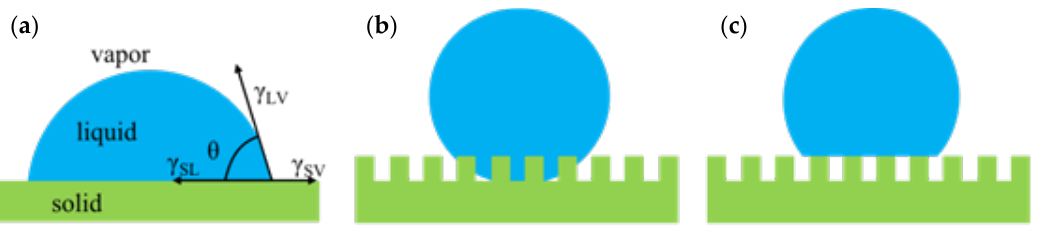
Figure 1. Different wetting behaviors of the solid surface: ( a ) Young state; ( b ) Wenzel state; and ( c ) Cassie state.